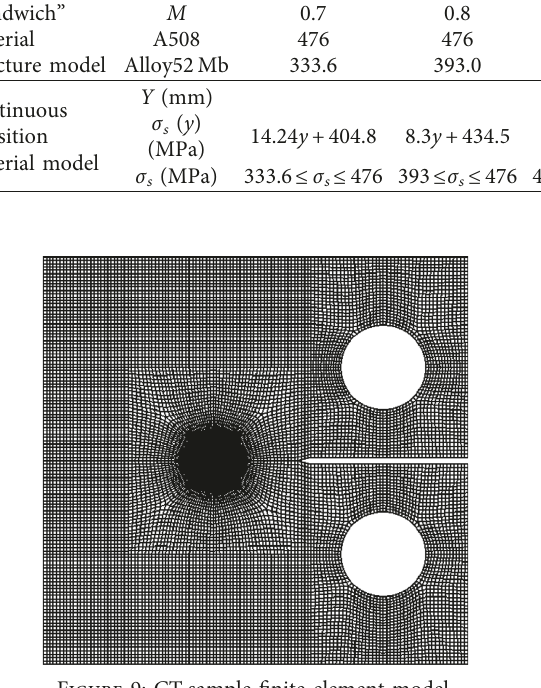
Figure 10: Crack tip local grid.